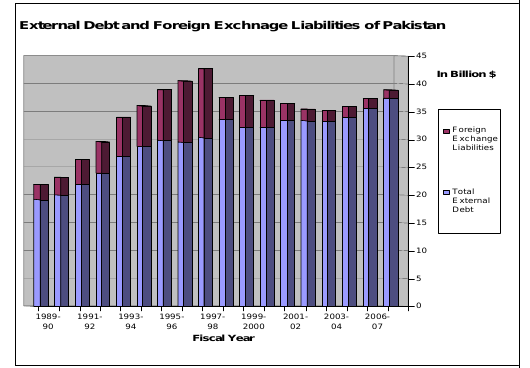
Graph 1 Source: Different economic surveys of Pakistan Graph 2 below shows debt servicing for Pakistan for the period falling between 1988 and 2007. The trend has been fairly consistent in the Democratic Era. However, the trend line took a nosedive in the years following 2001 and almost back to original levels in 2003-4 in the Military Era.